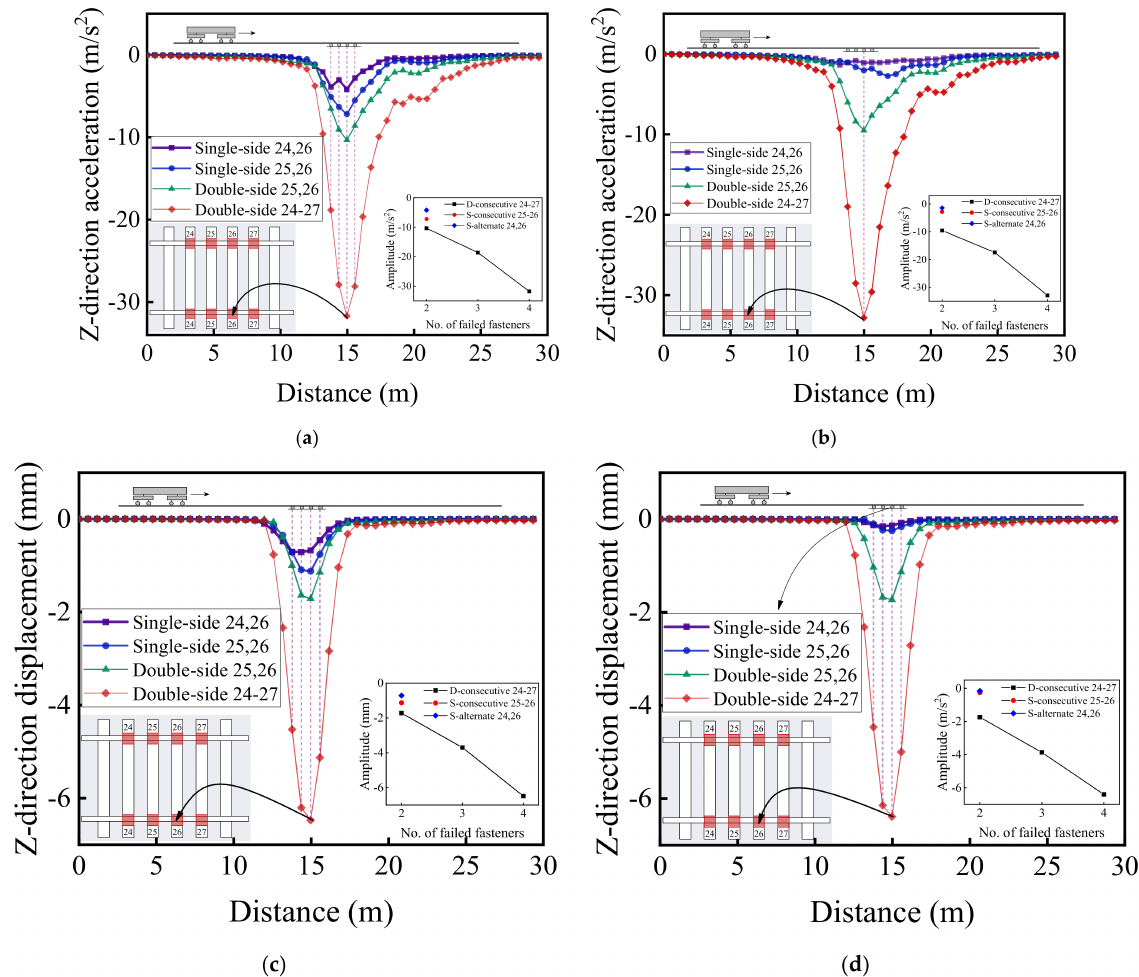
Figure 28. The longitudinal variations of dynamic responses of left and right rails with different patterns of rail fastener failure: ( a ) vertical acceleration of left rail; ( b ) vertical acceleration of right rail; ( c ) vertical displacement of left rail; and ( d ) vertical displacement of right rail.